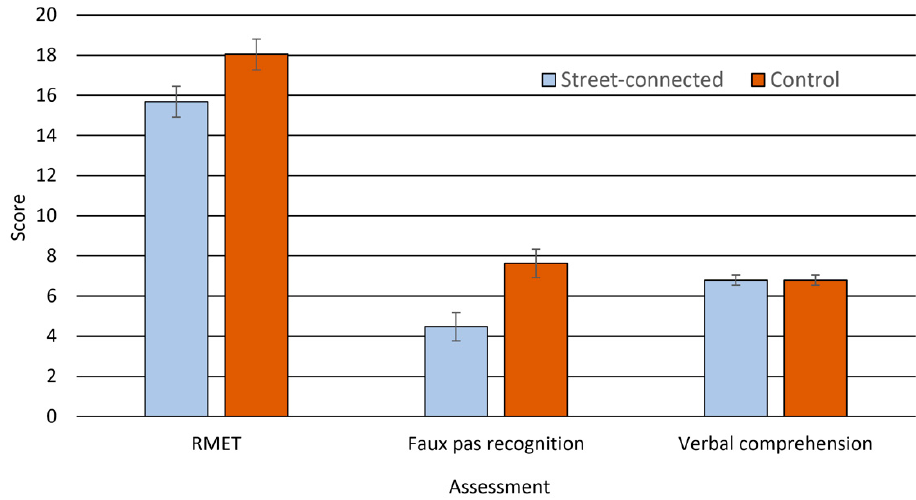
Figure 1. Mean (+SEM) for performance of theory of mind tasks and verbal comprehension by the 25 matched pairs of street-connected and control participants.